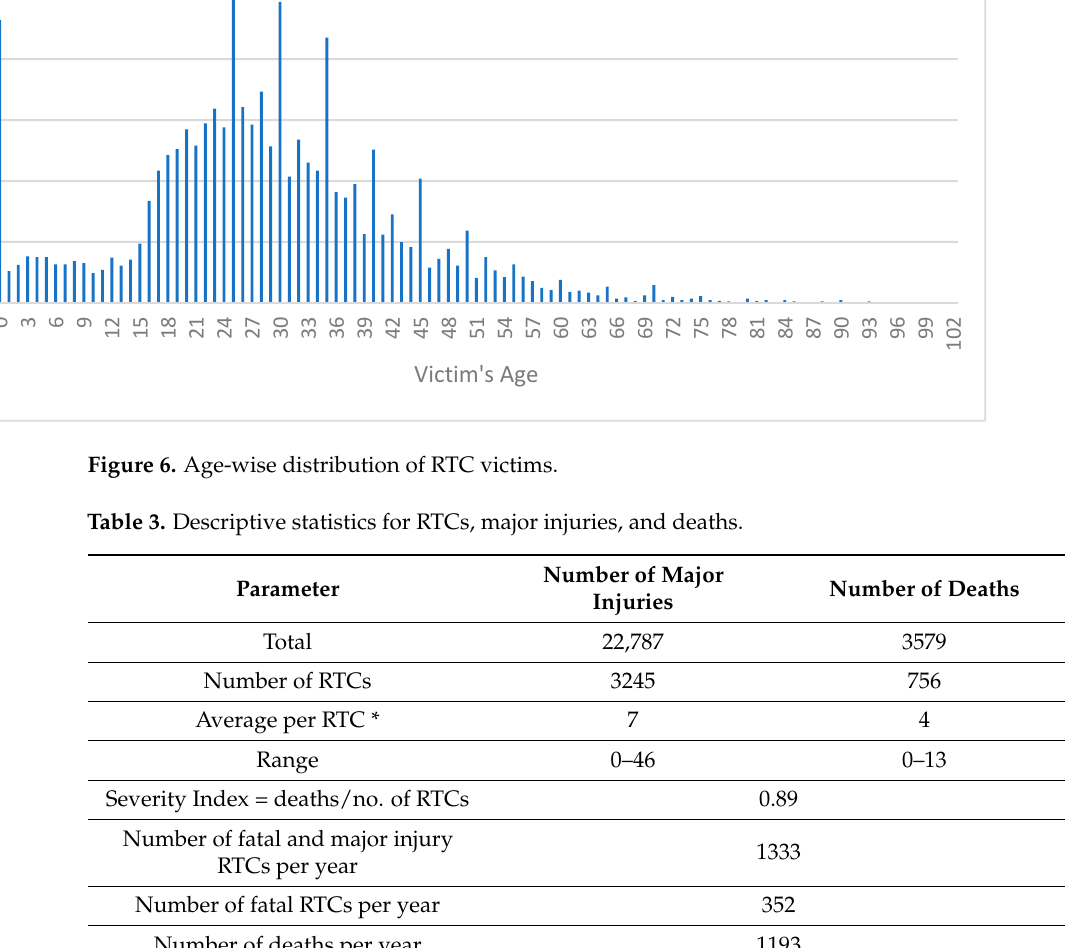
Table 4. Description of modeling parameters.